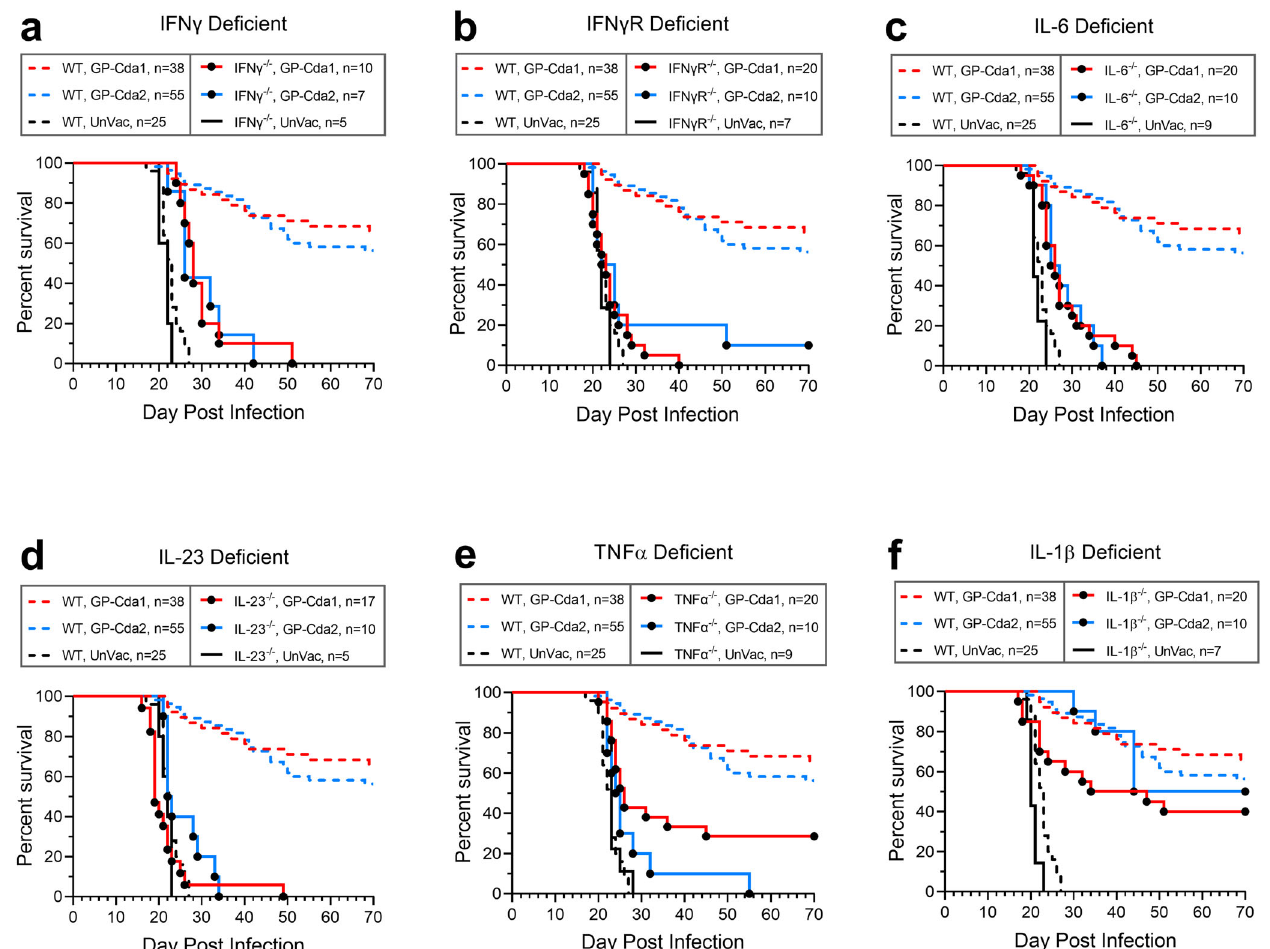
Fig. 7 Effect of host gene deletions in selected cytokines or cytokine receptors on GP-Cda1 or Cda2 vaccine ef fi cacy. Wild-type (WT) mice and mice with selected cytokine or cytokine receptor de fi ciency ( a . IFN γ − / − ; b . IFN γ R − / − ; c . IL-6 − / − ; d . IL-23 − / − ; e . TNF α − / − ; f . IL-1 β − / − ) received a prime and two biweekly boosts with GP-Cda1 or GP-Cda2. Two weeks after the last boost, mice were challenged with C. neoformans and followed for 70 days for survival. UnVac unvaccinated. n denotes the number of mice in the experimental group. All mice were on the C57BL/6 background. Note the same survival curves are shown for WT mice in Fig. 7a – f. For Fig. 7a – e, P < 0.001 (Mantel – Cox log-rank test) comparing survival between knockout and WT mice vaccinated with either GP-Cda1 or GP-Cda2. For Fig. 7f, P < 0.05 (Mantel – Cox log-rank test) comparing GP-Cda1-vaccinated IL-1 β − / − and WT